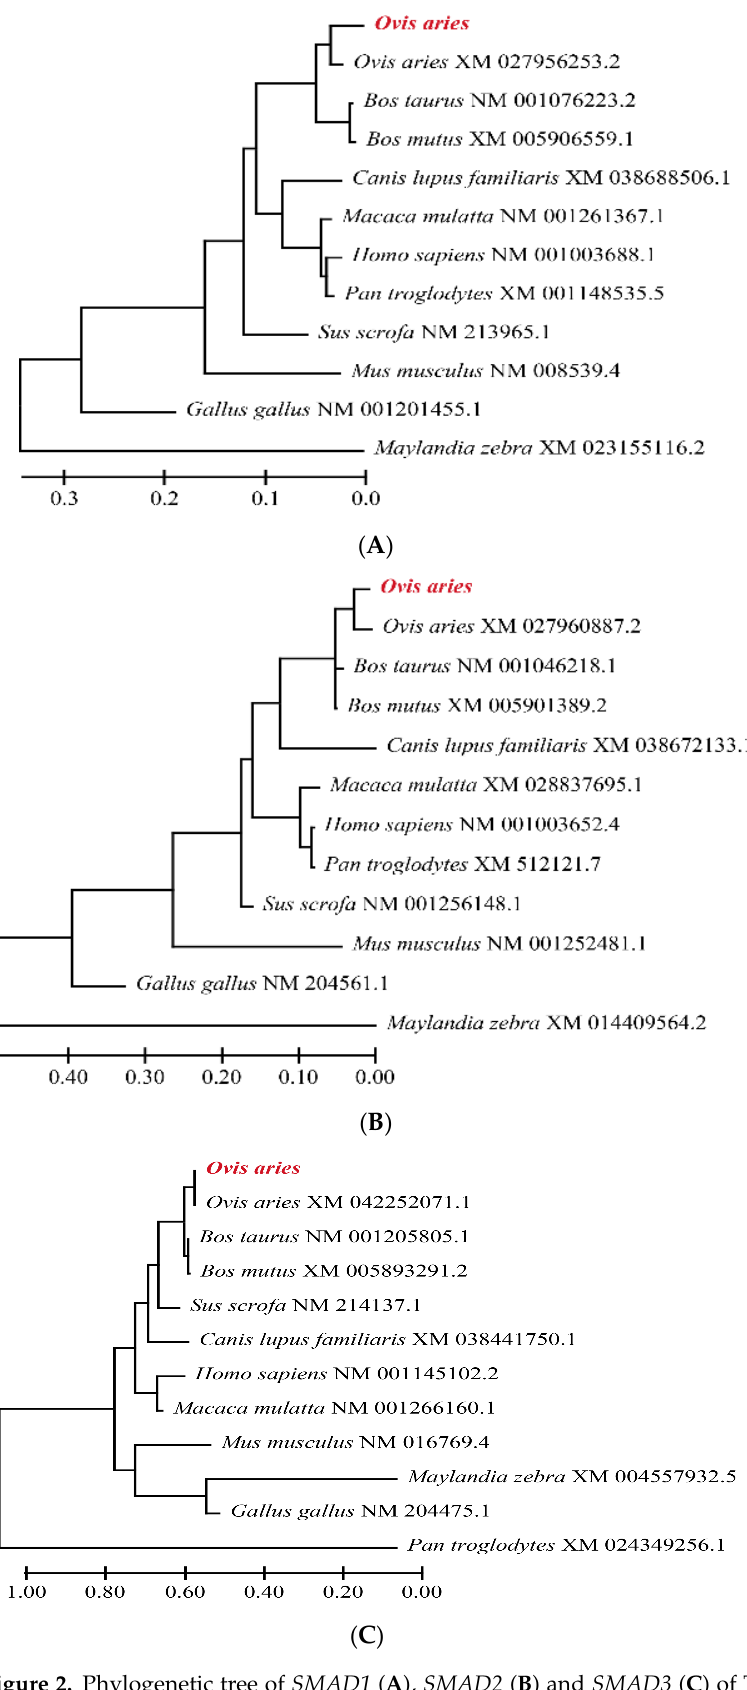
Figure 2. Phylogenetic tree of SMAD1 ( A ), SMAD2 ( B ) and SMAD3 ( C ) of Tibetan sheep with 11 other species. The red highlighted text is the species studied in this article.